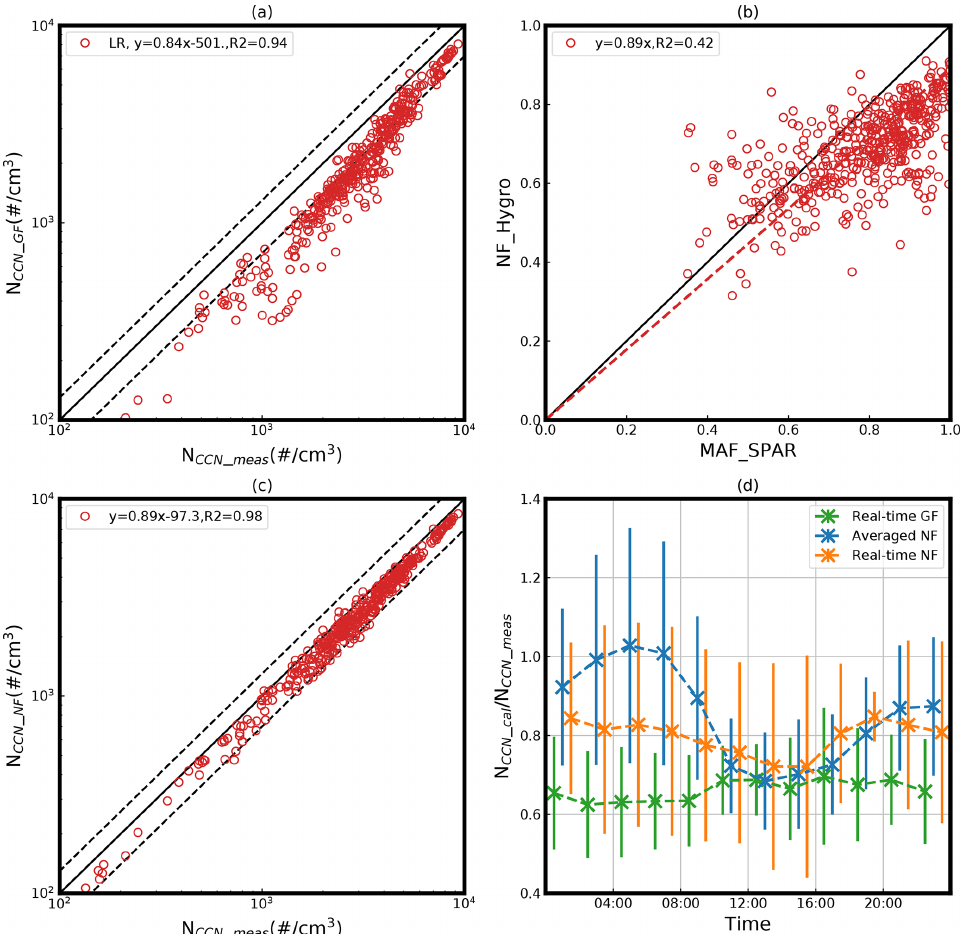
Figure 7. (a) The comparison between calculated N CCN based on κ derived from bulk GF at 200nm ( N CCN_GF ) and measured N CCN at SS of 0.05%. (b) The correlation between MAF and number fraction of hygroscopic particles (NF hygro , GF > 1.2). (c) The comparison between calculated N CCN based on SPAR derived from real-time NF hygro and average D a ( N CCN_NF ) and measured N CCN . The dashed black lines represent the relative deviation of 30%. (d) The diurnal variations of the ratio between the calculated and measured N CCN during the whole campaign based on different methods (green: N CCN_GF ; blue: N CCN based on SPAR derived from averaged NF hygro and average D a ; yellow: N CCN_NF